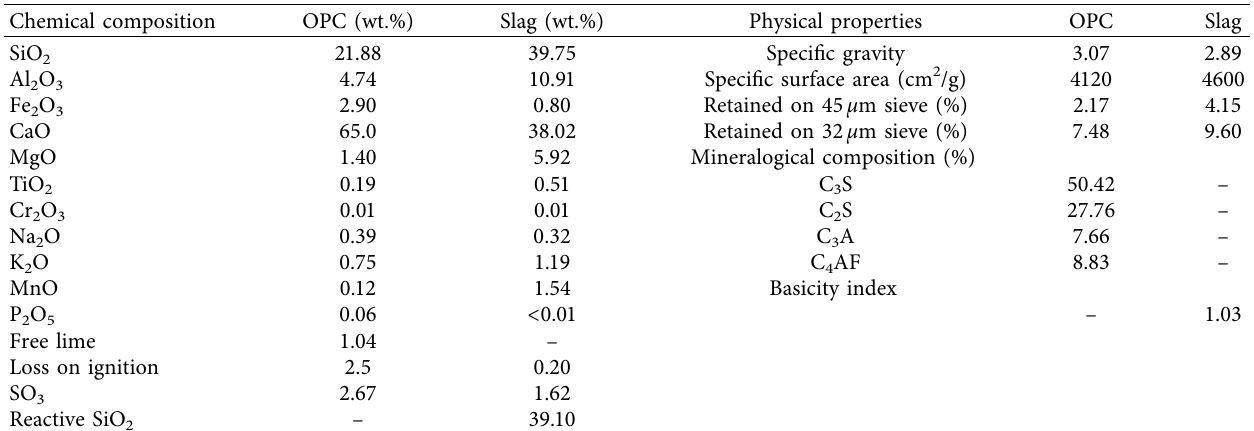
Table 2: Chemical, physical, and mineralogical properties of